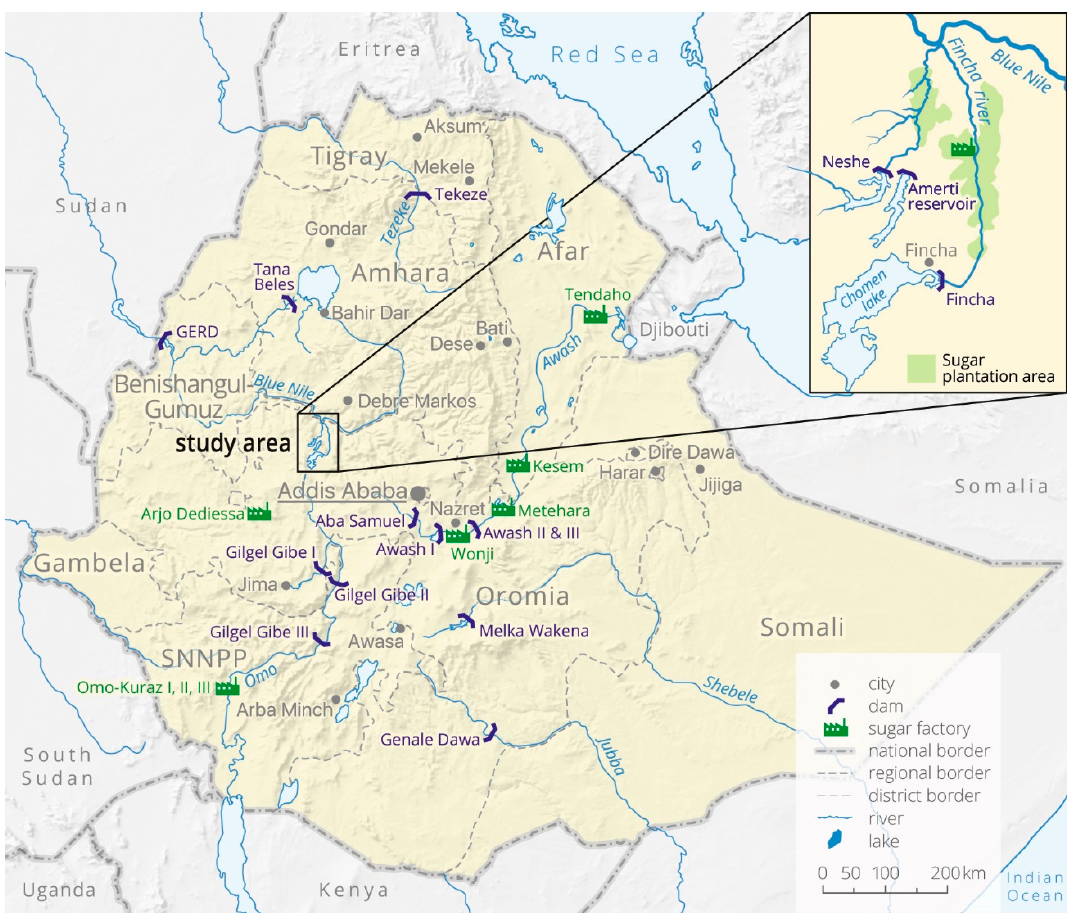
Figure 1. Major dam sites and location of the study area in Ethiopia.